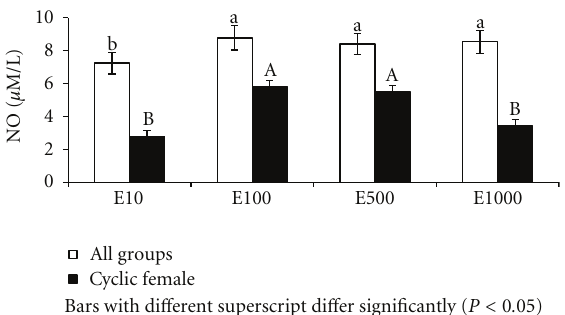
Figure 3: NO in culture supernatant supplemented with di ff erent levels of estradiol in Murrah bu ff aloes.